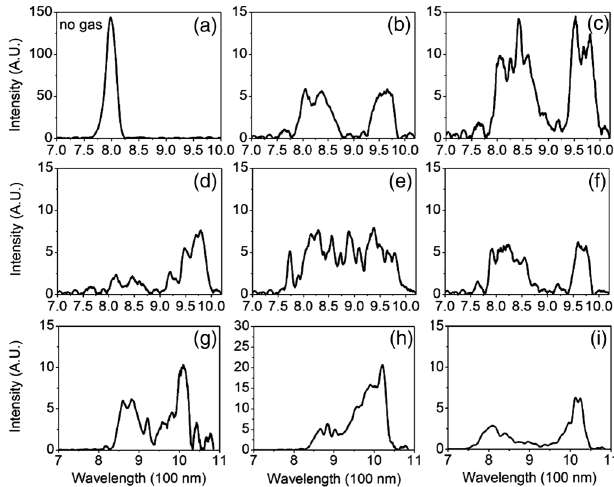
FIG. 3. The transmitted laser spectra at two different plasma densities: (a) without interaction with plasma, (b) to (f) with ’ 6 : 5 (cid:8) 0 : 5 (cid:3) 10 19 cm (cid:4) 3 , for grating separa- interaction at n e tion of 0 (45 fs), (cid:4) 320 (cid:3) m (70 fs), (cid:4) 600 (cid:3) m (125